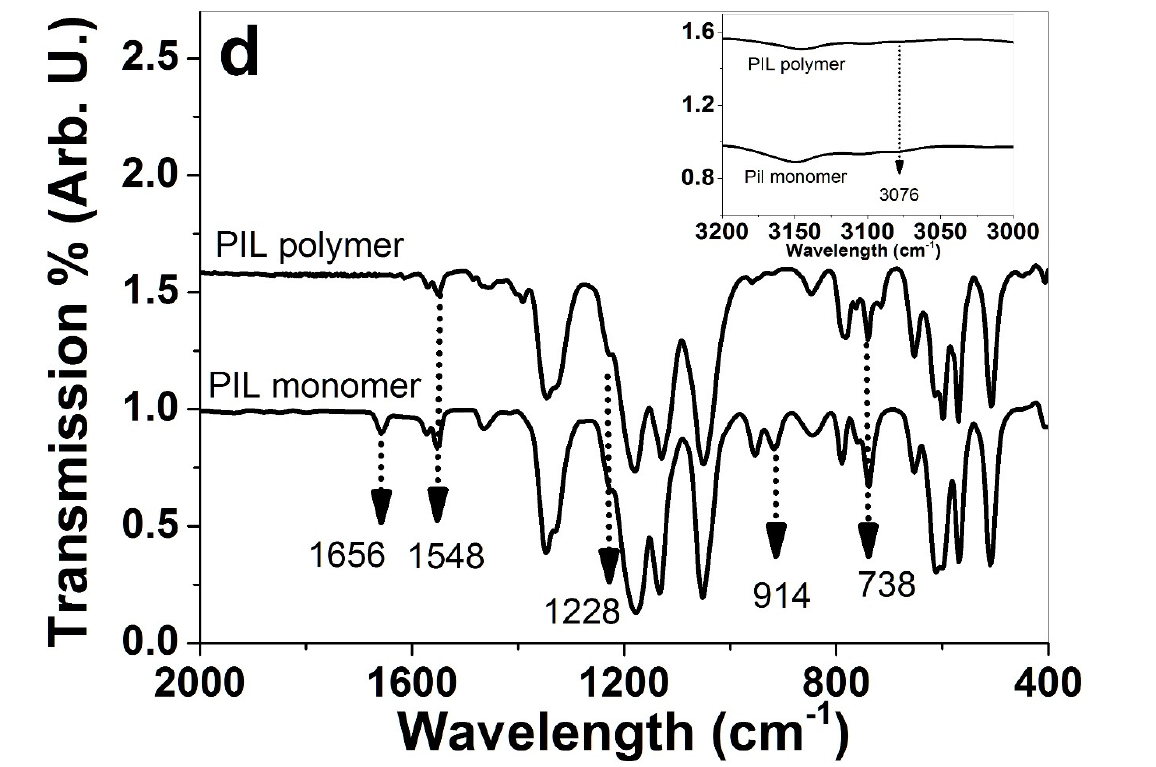
Figure 1. ( a ) C6VImTFSI monomer polymerization to PIL polymer with SEM surface image of PIL-TFSI polymer. The 13 C MAS-NMR spectra (160 ppm to 0 ppm) of ( b ) PIL-monomer C6VImTFSI, ( c ) PIL polymer film and ( d ) FTIR spectroscopy from 2000 cm − 1 to 400 cm − 1 , with inset 3200 to 3000 cm − 1 , for the PIL monomer and PIL polymer.